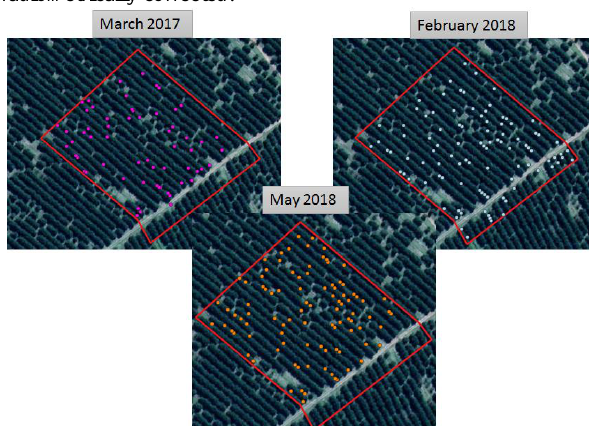
Figure 5. Orthophotomosaic radiometrically corrected.